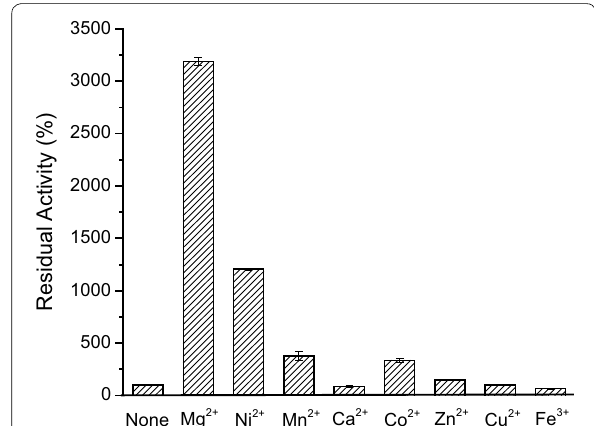
Fig. 3 Effects of cations on the specific activity of AfPase. The reactions were performed in 100 mM HEPES buffer (pH 7.0) containing 1 mM p -nitrophenyl phosphate, 5 mM different ions, and appropriate concentration of phosphatase at 85 °C